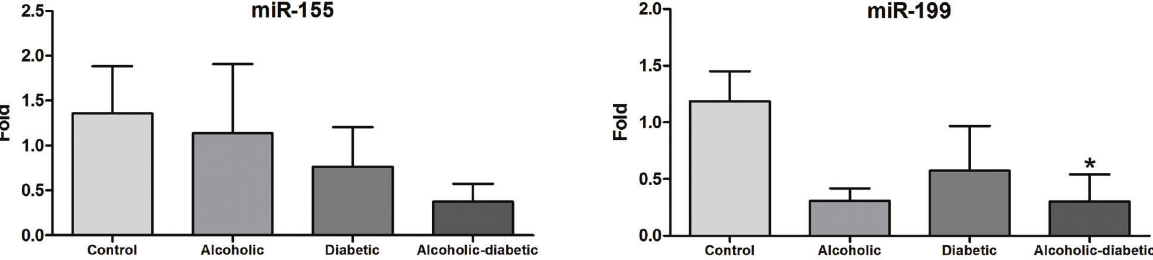
Figure 4. Mean ( ± standard error) of microRNAs-155 and -199 expression in the cavernous tissue samples of the groups studied. *P o 0.05, compared to the control group (Kruskal-Wallis test, Dunn ’ s post-test).